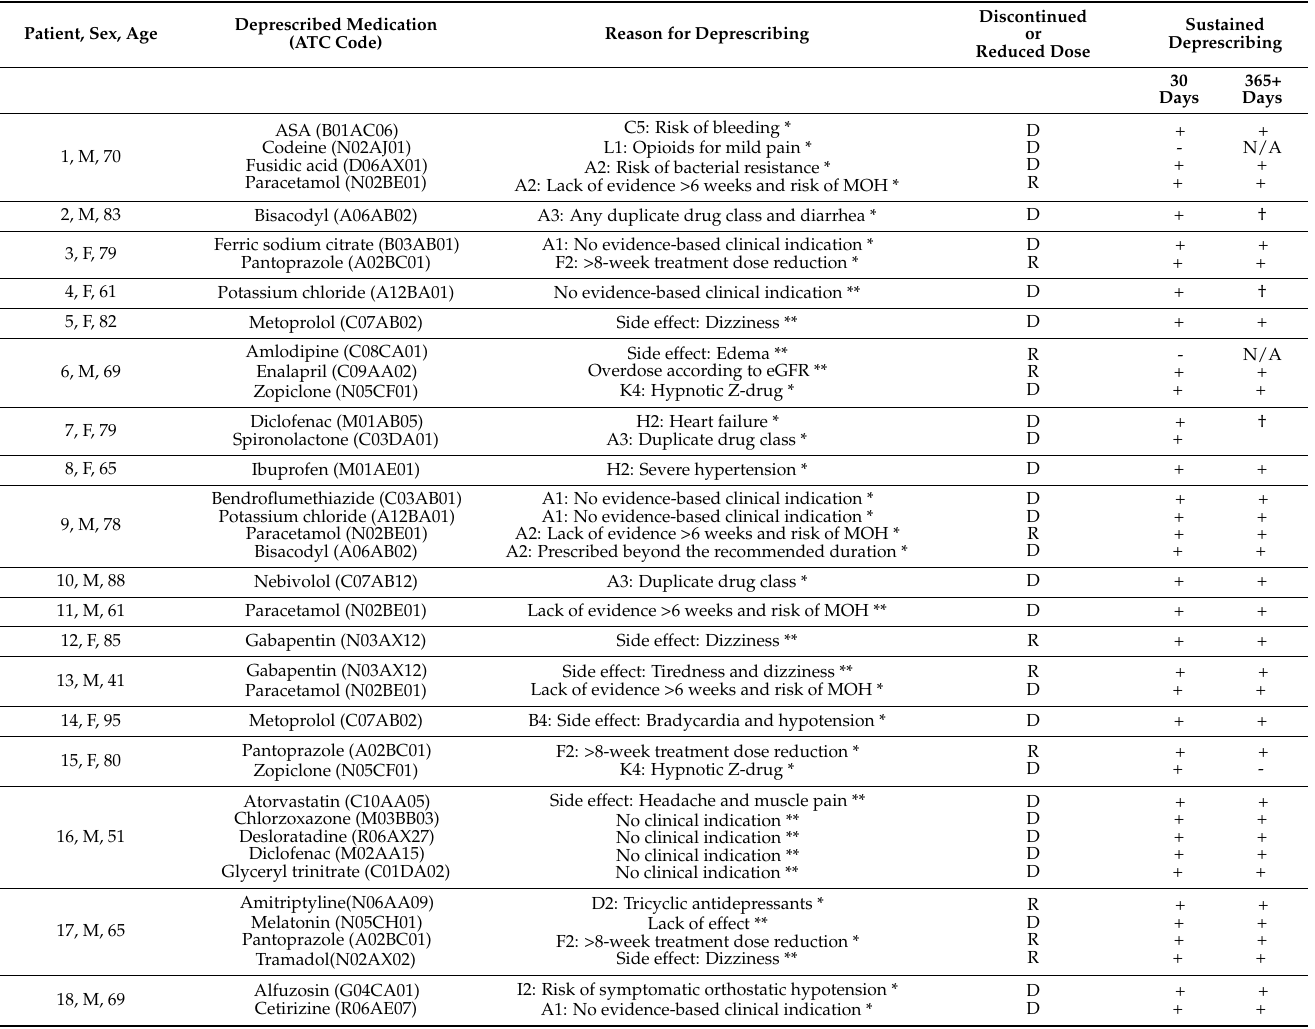
Table A1. Detailed overview of each deprescribed medication, reason for deprescribing, and whether the deprescribing status was sustained at 30 days and 365+ days post inclusion in the intervention